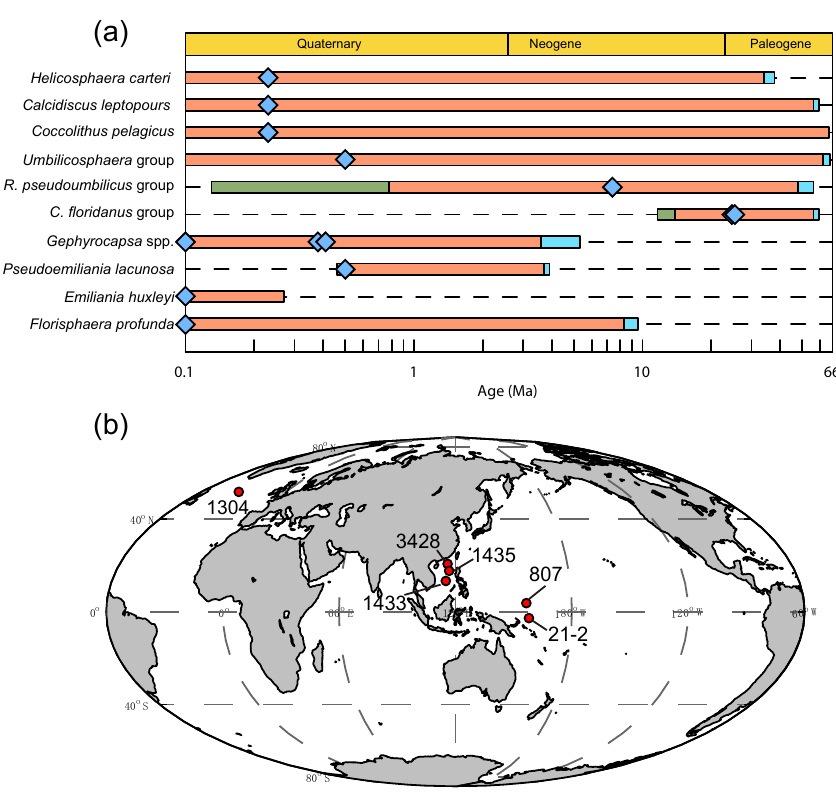
Figure 1. Temporal and spatial distribution of samples. (a) The evolution of studied coccoliths: first occurrence and last occurrence data are from Nannotax3 (http://www.mikrotax.org/Nannotax3/index.html). The blue bars represent ranges of first occurrence and the green bars represent ranges of last occurrence. The blue diamonds represent samples used in this study. (b) Spatial distribution of samples. Regarding the numbers on the map, 1304 means IODP U1304; 3428 means MD12-3428cq; 1433 and 1435 mean IODP U1433 and U1435, respectively; 807 means ODP 807, and 21-2 means